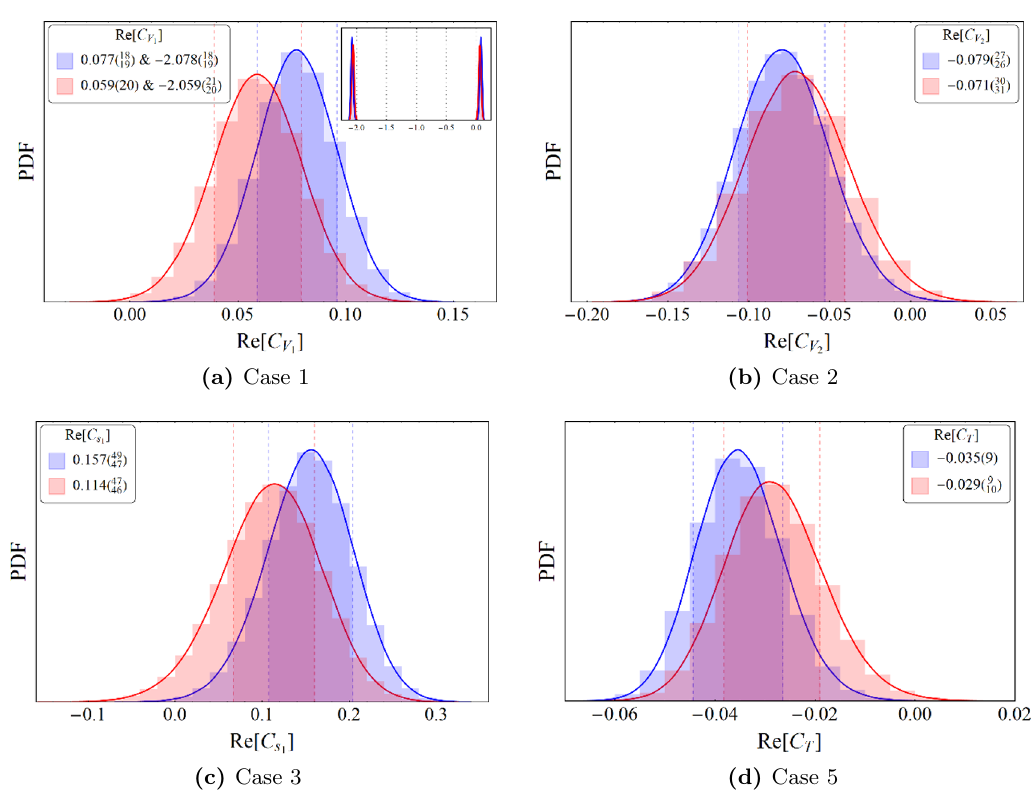
Figure 4. 1D marginal posterior distributions for the NP WCs for the allowed one parameter scenarios in tables 8 and 9. The blue ones are obtained with all the experimental inputs in table 7 while for the red ones, we dropped the inputs from BaBar. The region between the dashed lines contain 68% credible intervals (high density region around mode) and the corresponding values are also listed. The marginal for R e [ C V ] (Case 1) has two distinct modes (shown inset (cid:12)gure 4a) but 1 we focus on the mode corresponding to lowest absolute value for the WC.